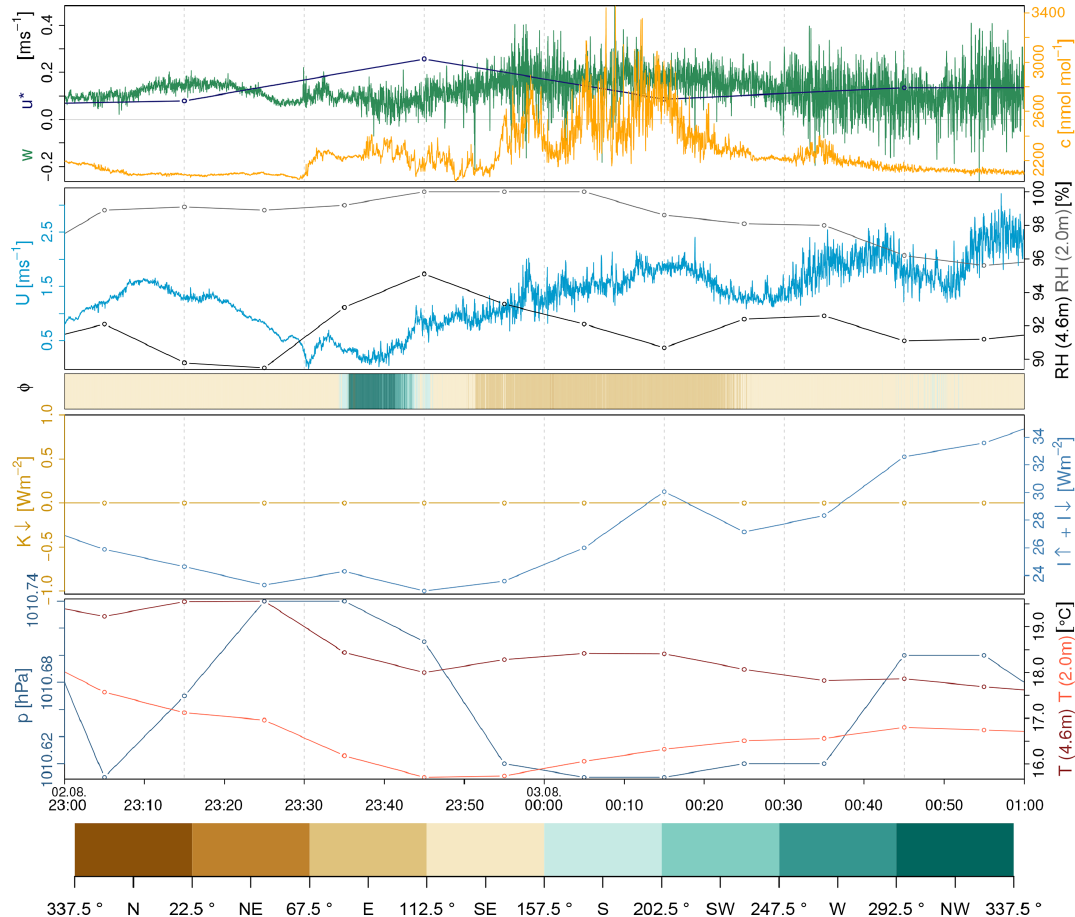
Figure 2. Meteorological conditions observed at tower 1 during the case study event of 2–3 August 2014. Wind velocity U , vertical wind speed w , and CH 4 mixing ratio c as well as wind direction φ are shown in a time resolution of 20Hz. The friction velocity u ∗ was averaged to 30min, while all other data were averaged to 10min: relative humidity RH and air temperature T (both in each 2.0 and 4.5ma.g.l.) as well as the longwave radiation balance I ↓ + I ↑ , the shortwave downwelling radiation K ↓ , and air pressure p . The bottom panel shows a legend for φ